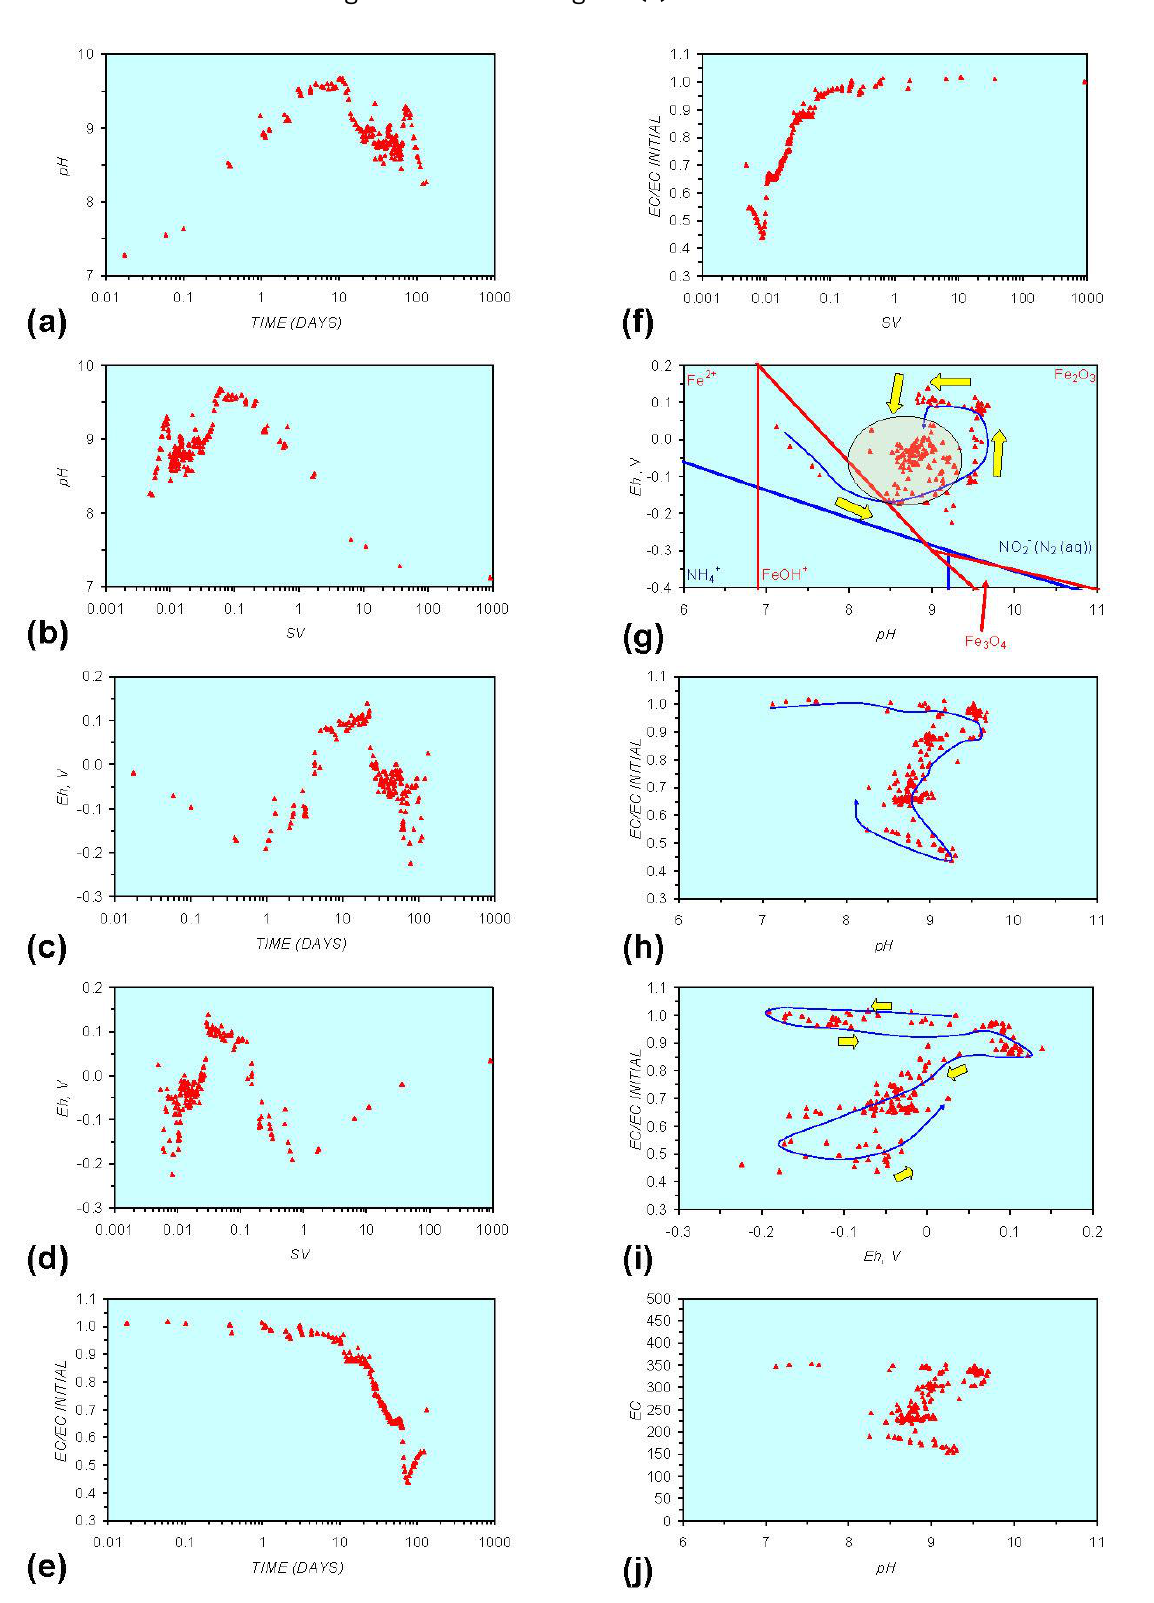
Figure A5. MR5: n-Fe 0 + n-Al 0 + n-Cu 0 , fresh water. (a) pH vs. Time; (b) pH vs. SV; (c) Eh vs. time; (d) Eh vs. SV; (e) EC/EC Initial vs. time; (f) EC/EC Initial vs. SV; (g) Eh vs. pH (SRE ringed); (h) pH vs. EC/EC Initial; (i) Eh vs. EC/EC Initial; (j) pH vs. E(C) Arrows indicate decreasing SV and increasing